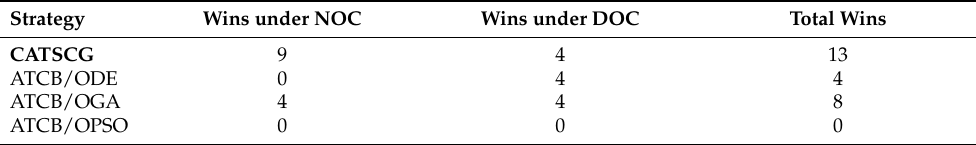
Table 9. Summary of the post hoc Friedman test over the values of ISE for the adaptive controller